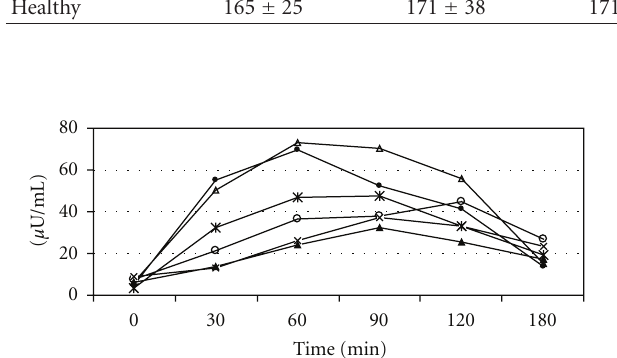
Figure 2: Mean serum insulin level at timed intervals during glucose tolerance test for 10 diabetic and 10 healthy participants. Mean serum insulin levels in µ U/mL without (o) and with 125 ( • ) and 250 mg ( × ) ingestion of Tinospora crispa in diabetic participants, and without ( (cid:2) ) and with 125 ( (cid:3) ) and 250 mg ( ∗ ) ingestion of Tinospora crispa in healthy